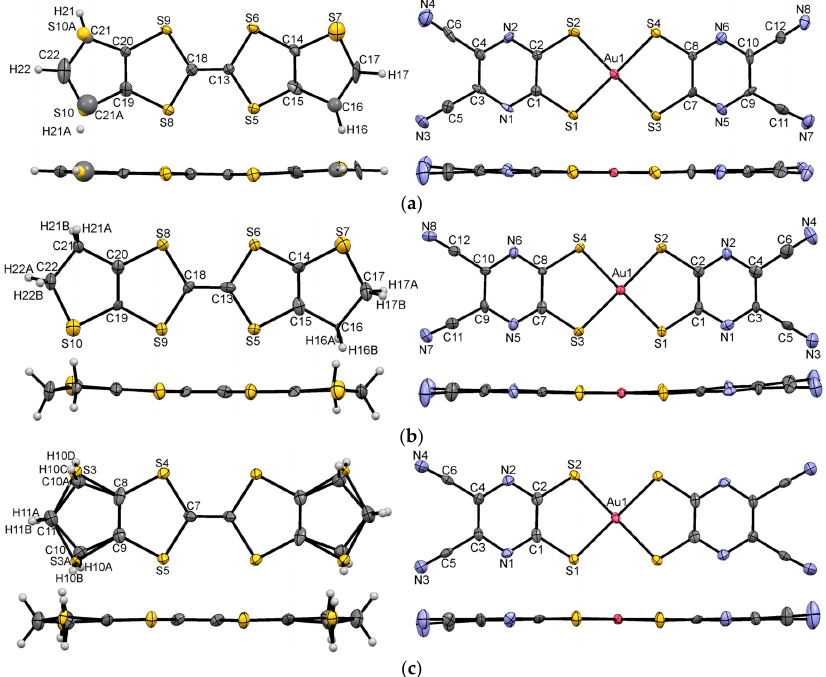
Figure 1. ORTEP and atomic numbering schemes (top and side views) of ( a ) α -DT-TTF donor molecule and acceptor [Au(dcdmp) 2 ] molecule in the crystal structure of 1 ; and ( b , c ) BET-TTF donor molecule and acceptor [Au(dcdmp) 2 ] molecule in the crystal structure of 2 : ( b ) structure M ( 2M ) and ( c ) structure T ( 2T )). Thermal ellipsoids drawn at 70% probability level. The crystal structure of 1 is composed of mixed stacks of alternating donor-acceptor molecules (D + A − D + A − D + A − ) along the a axis (Figure 2a). Along the stacks there are no short contacts below the sum